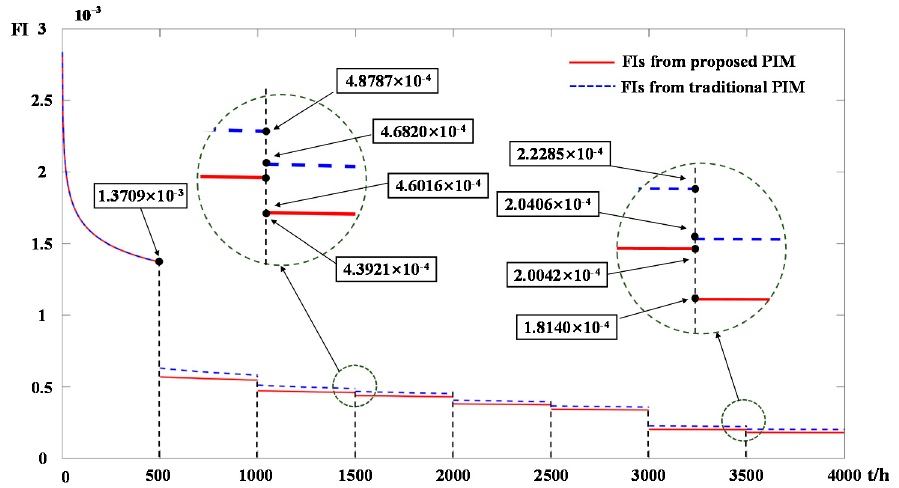
Figure 5. The FI results of the two PIM models. Table 3. The results at specific points in time.